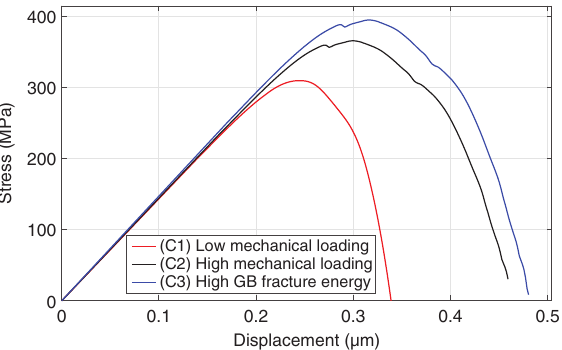
Figure 7: Comparison of the stress-displacement curve for both dif- ferent mechanical loading